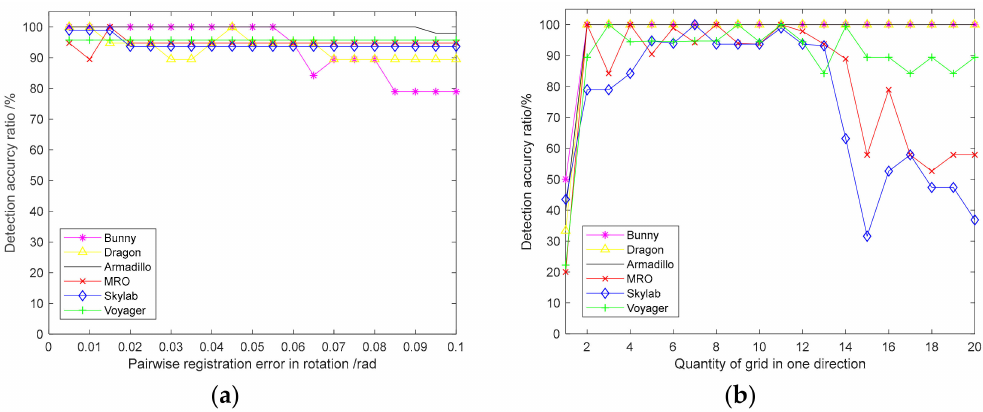
Figure 6. Relationship between detection accuracy and related factors. ( a ) The relation between detection accuracy and the pairwise registration error; ( b ) the relation between detection accuracy and the quantity of